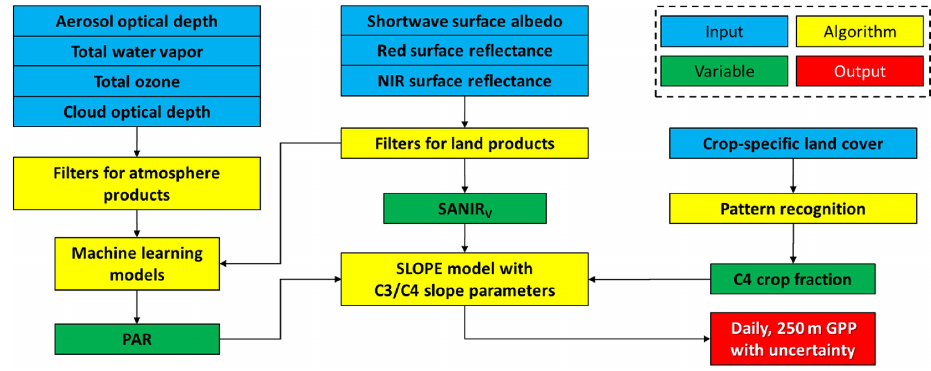
Figure 1. Framework to produce the SLOPE GPP product. The box with dashed lines is the